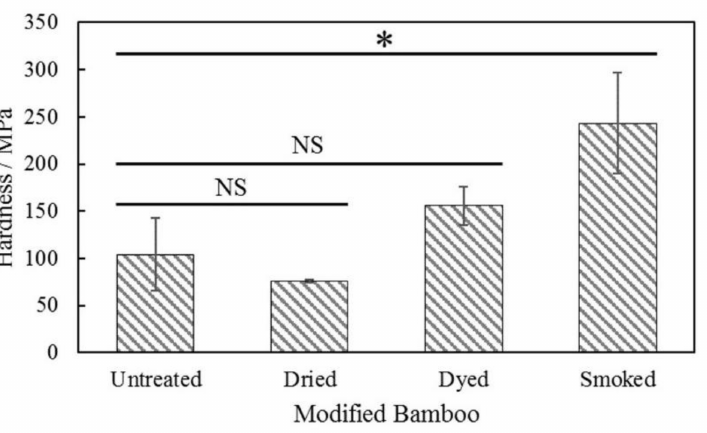
Figure 10. Hardness evaluation of longitudinal-radial section of untreated and modified bamboo specimens (* statistically significant difference, NS = no significant